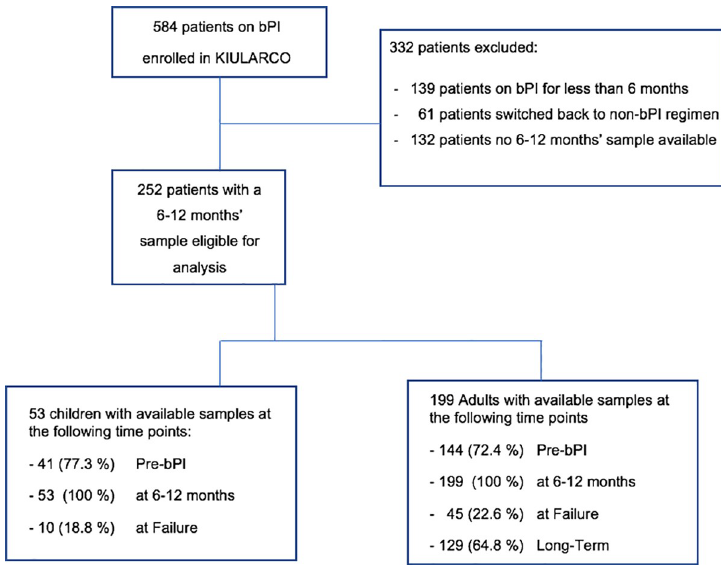
Fig 1. Overview of available samples from included patients. Profile of the study cohort on second-line at the Chronic Disease Clinic Ifakara in Ifakara, Morogoro, Tanzania. (KIULARCO Kilombero and Ulanga Antiretroviral Cohort; bPI boosted Protease Inhibitors; FUP